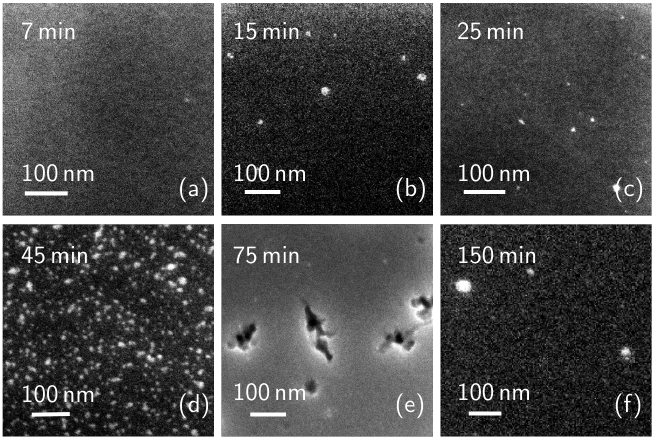
Figure 2. SEM plan images of the cleaned samples at ( a ), 15 ( b ), 25 ( c ), 45 ( d ), 75 ( e ), 150 ( f ) minutes. Despite the cleaning process, from the analysis, we observe that all the samples present the molecules on their surface, even though the surface density is lower with respect to the as-deposited samples, especially for the low deposition times. Evidently, these molecules have not been removed by the surface cleaning process, which can probably be attributed to the covalent nature of their bonds with the Si surface. The sample dip-coated for 7 min (Figure 2a) presents a surface coverage of 0.3%. Figure 2b (15 min) and Figure 2c (25 min) have a very similar morphology: both of these samples present sparse molecule nucleation spots, covering 3% and 2%, respectively. Figure 2d,e show a SEM plan image of a dip-coated sample for 45 and 75 min, respectively. The calculated surface coverage is 15% (45 min) and 86.2% (75 min), values in accordance with the as-deposited samples (Figure 1d,e) within experimental errors. Figure 2f shows the surface morphology of a 150 min dip-coated and cleaned sample. In this image, we can see that the surface appears mostly flat, with some molecule clusters with a bright appearance. The surface coverage of this sample is 103%, accounting for a 100% coverage molecule layer, plus a 3% coverage of the molecule clusters over the first layer. Also these data will be discussed below. Surface coverage data from both sets of samples are represented in the graph of Figure 3. In this image, blue dots represent data from the as-deposited samples, while orange squares represent coverage of the cleaned samples. Coverage over 100% indicates the completion of the first layer and the deposition of a second layer on top of the